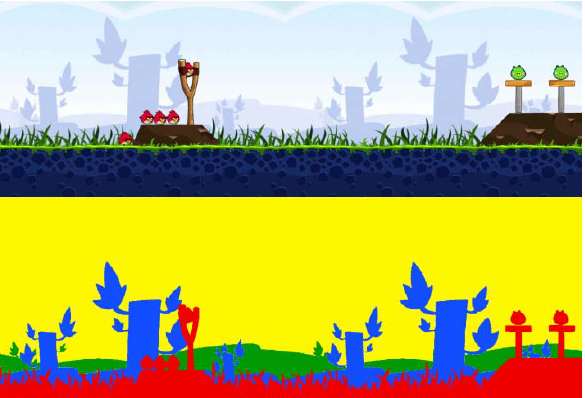
Figure 1. Depth illusion with layers (angry birds